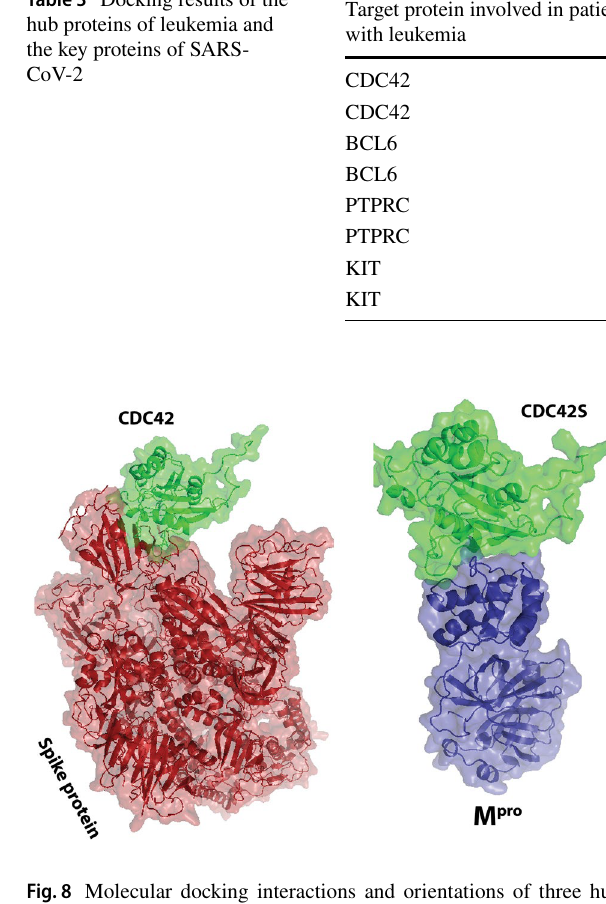
Fig. 8 Molecular docking interactions and orientations of three hub proteins in leukemia with SARS-CoV-2 spike protein and Mpro. Docking interactions of A CDC42. Visualization of interactions of these protein drug molecules with spike protein and Mpro, through